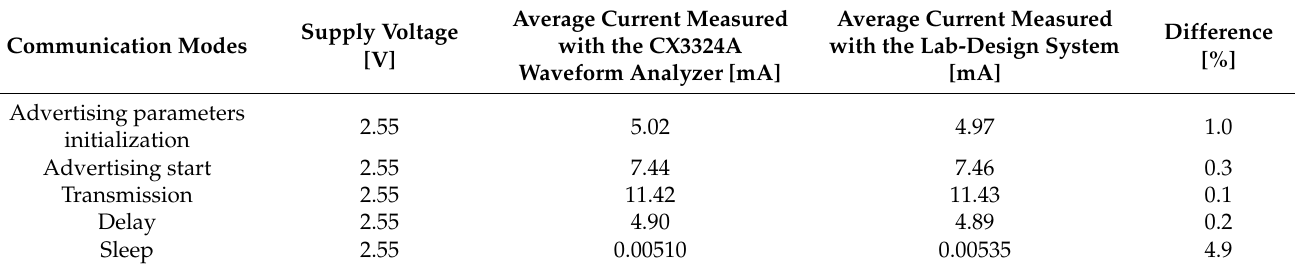
Table 3. Current consumption of the IoT device during the different BLE communication modes.